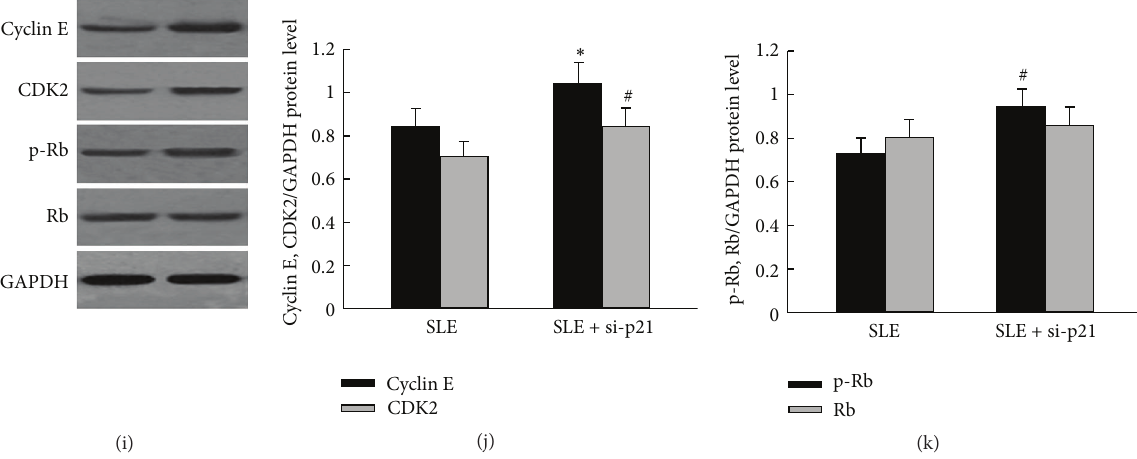
Figure 6: p21 knockdown reversed theageing characteristics of BM-MSCsfromSLE patients. (a) Themorphology of BM-MSCsshowed more spindle-shaped fibroblast-like growth after knockdown p21 when compared with BM-MSCs culture without si-p21. (b) Growth curve of BM- MSCs treated with and without si-p21 was tested by cell-counting assay. It has showed that, when p21 was knocked down, the cell proliferation rate was increased. Each point represents quantities relative to the BM-MSCs from SLE treated without si-p21 at Day 1 ( ∗ 𝑃 < 0.05 ) ( # 𝑃 < 0.05 ). ((c)-(d)) CFU of BM-MSCs from treated with si-p21 were increased; each bar represents quantities relative to BM-MSCs from SLE treated without si-p21 and is mean ± SD of three experiments ( # 𝑃 < 0.05 ). ((e)-(f)) After treated with si-p21, the number of SA- 𝛽 -gal-positive cells was obviously decreased; each bar represents quantities relative to BM-MSCs from SLE treated without si-p21 and is mean ± SD of three experiments ( # 𝑃 < 0.05 ). (g) DNA content between BM-MSCs culture with and without si-p21 from SLE patients was compared by flow- cytometry. (h) When BM-MSCs from SLE patients treated with si-p21, the percentage of cells in G0/G1 was obviously decreased, and increase in percentage of cells in S phases was seen in SLE patients. Each bar represents quantities relative to BM-MSCs from SLE treated without si-p21 and is mean ± SD of three experiments ( ∗ 𝑃 < 0.05 ; # 𝑃 < 0.05 ). ((i)–(k)) Expressions of cyclin E, CDK2, and p-Rb in BM-MSCs from SLE patients were tested by Western blot analyses and quantification analyses between culture with and without si-p21. The relative levels of protein expressions were normalized to GAPDH expression. Values are means ± SD of three experiments ( ∗ 𝑃 < 0.05 ; # 𝑃 < 0.05